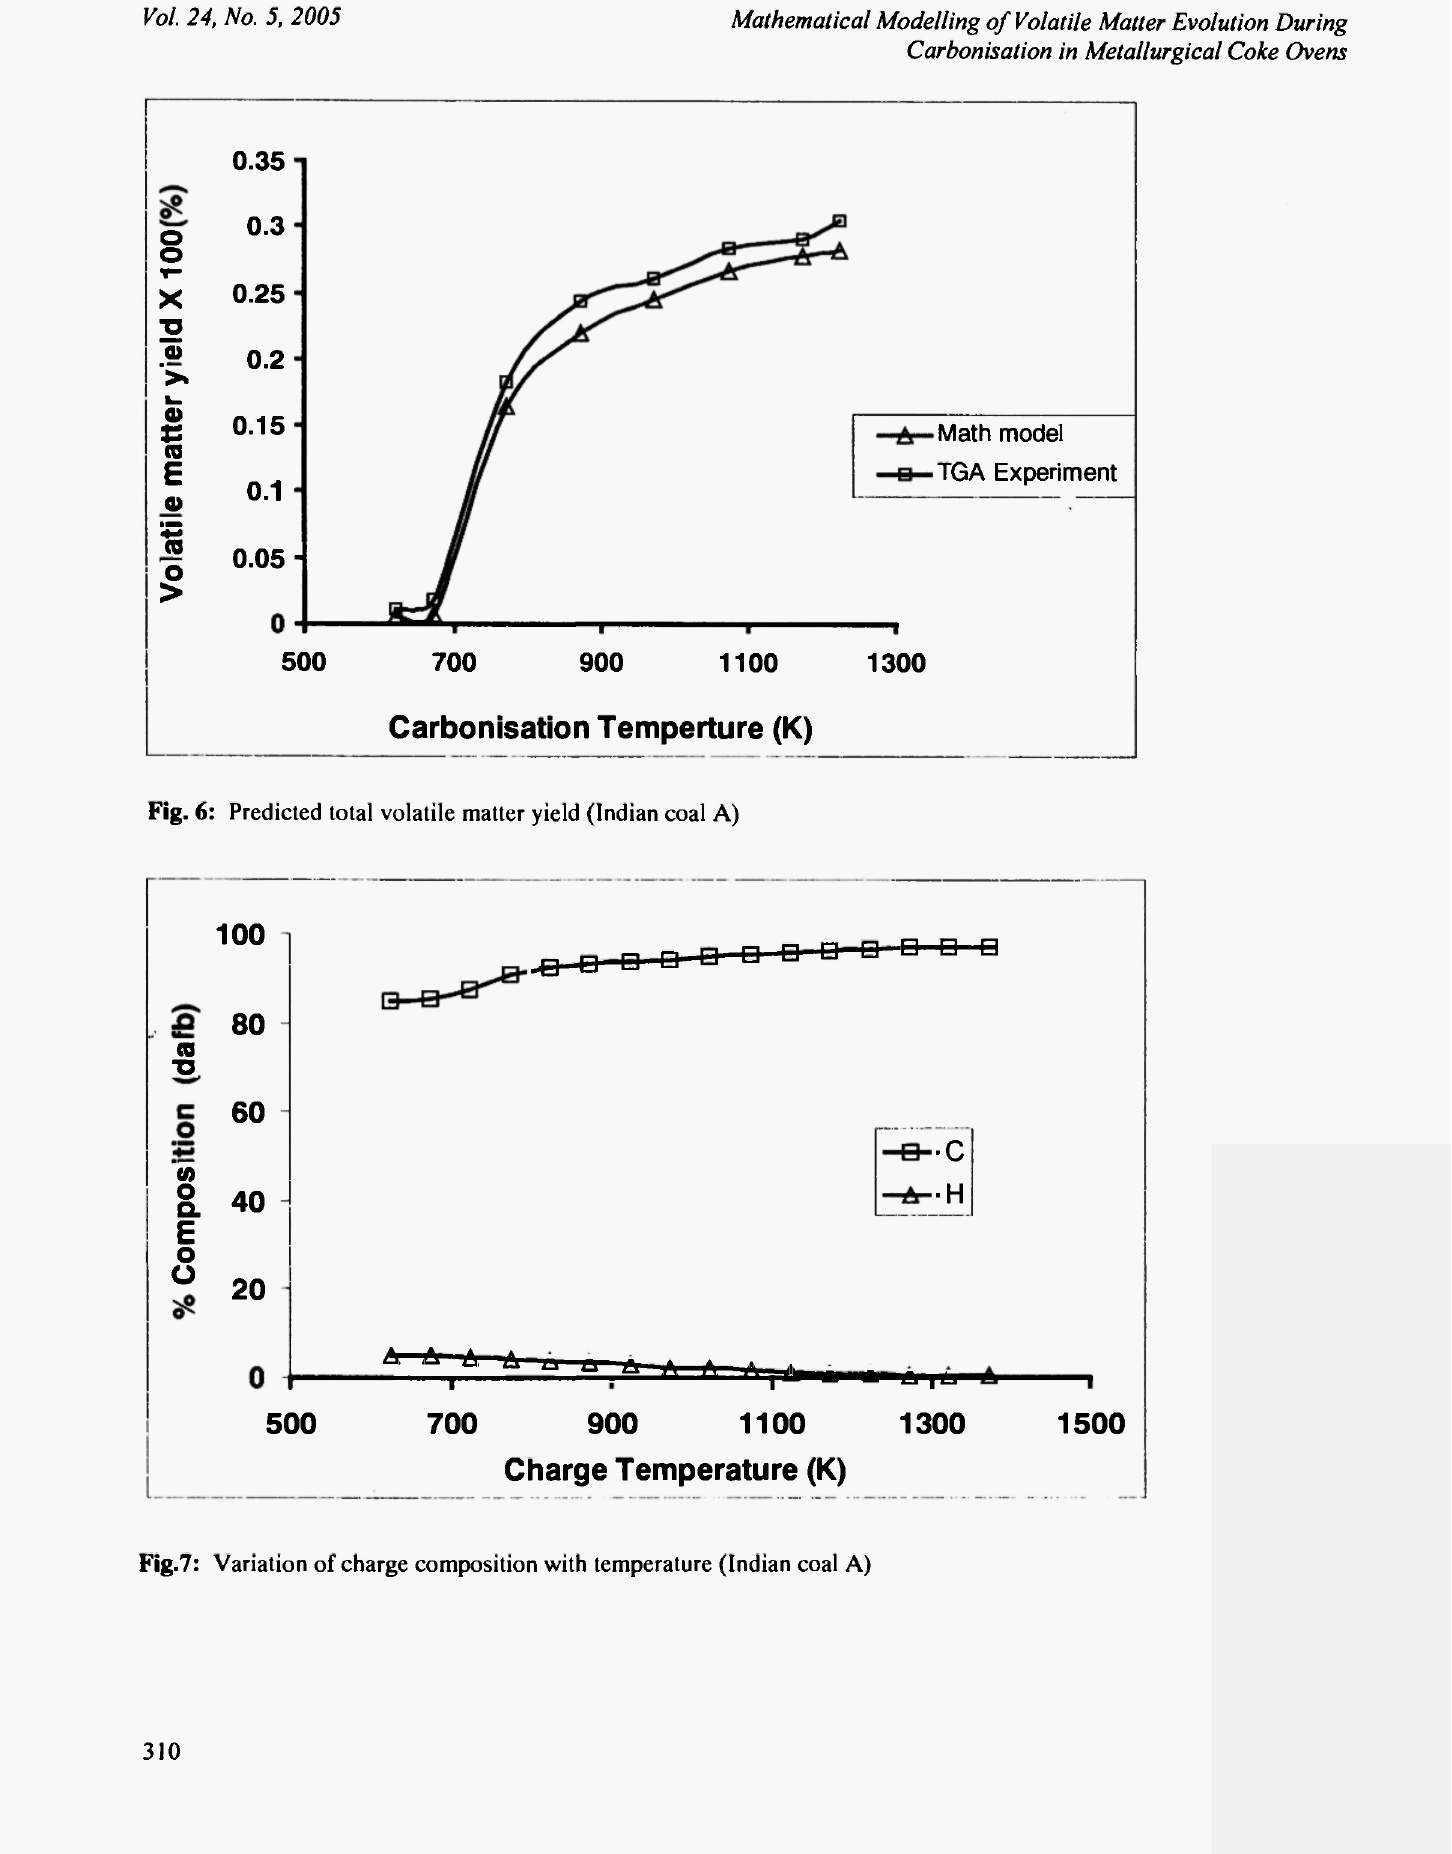
Fig.7: Variation of charge composition with temperature (Indian coal